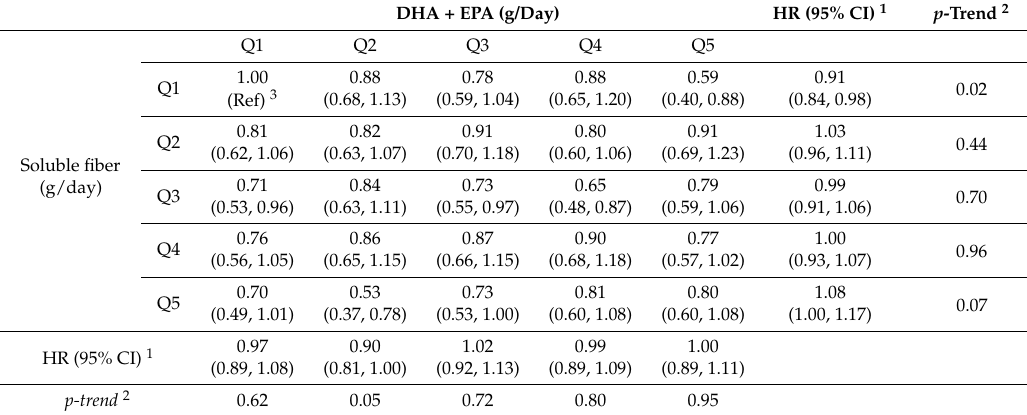
Table 4. Soluble fiber and DHA + EPA stratified by quintile of intake, and association with colorectal cancer in the Women’s Health Initiative ( n = 134,017)